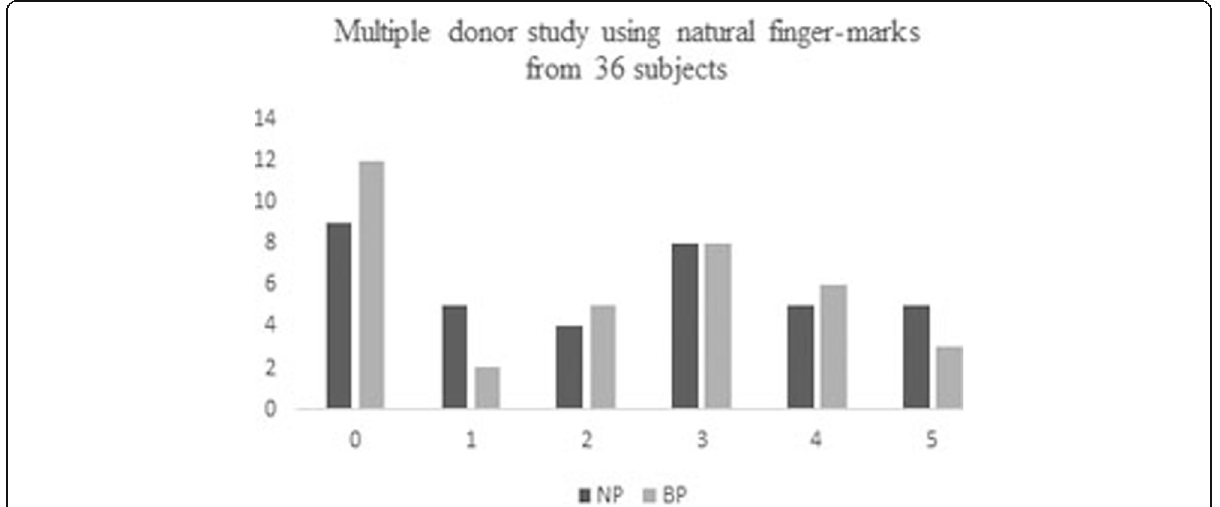
Fig. 4 Bar chart that reflects the cumulative number of fingermarks in each score